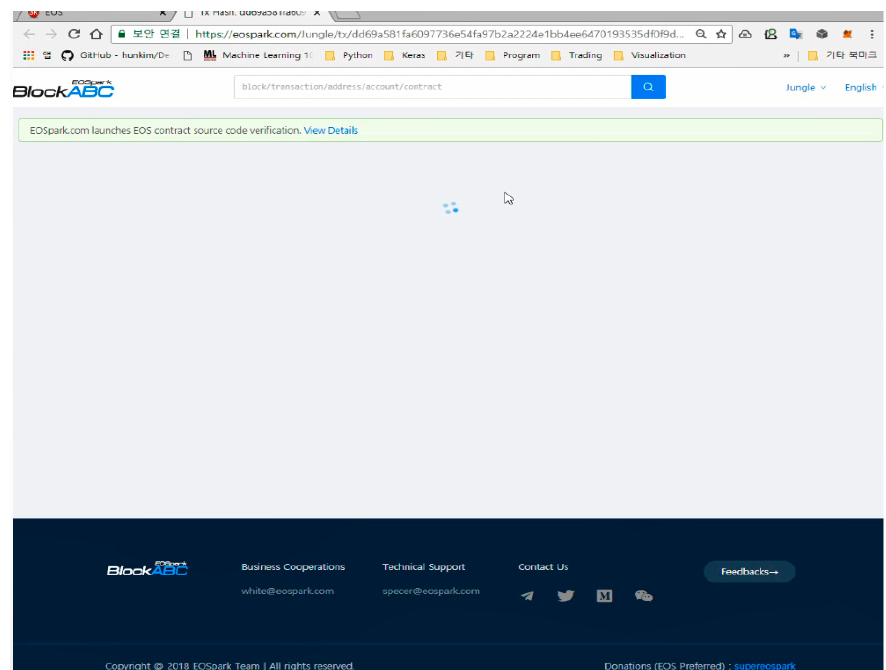
Figure 17. Real estate transaction Blockchain smart context contract results screen.